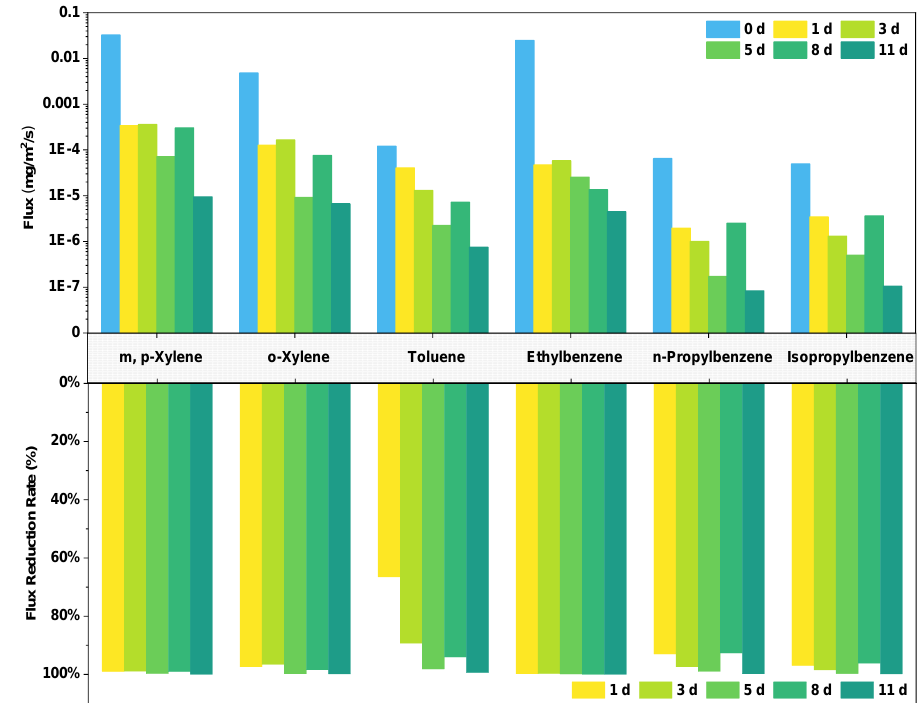
Figure 3. Diffusion flux and flux reduction rate of main odours before and after laying the PLA- modified